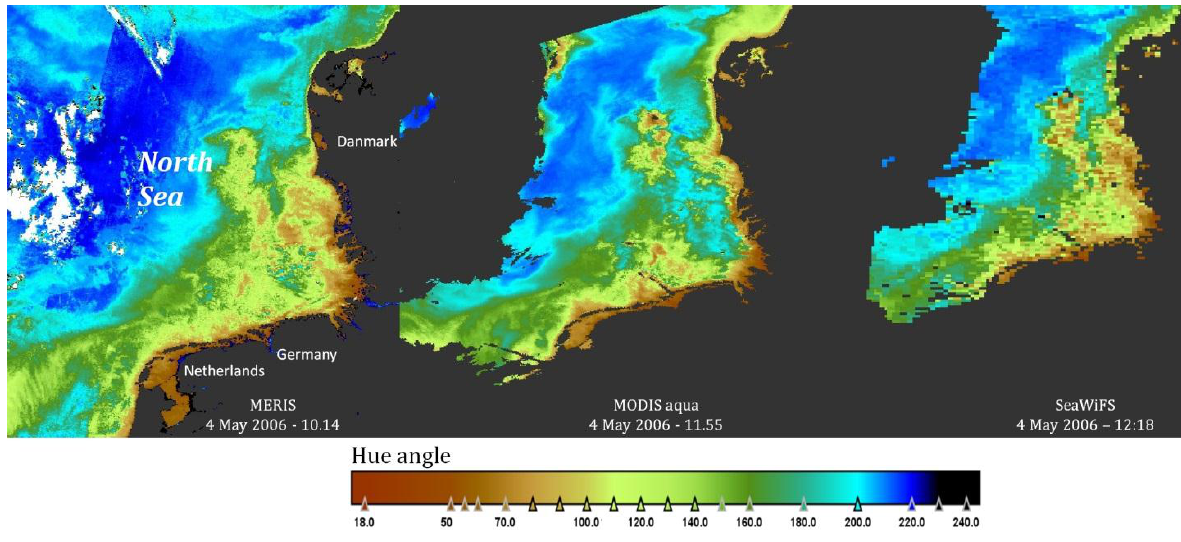
Figure 9. Hue angle image processing of MERIS, MODISA and SeaWiFS (left to right) with the code proposed in this manuscript. Area North Sea, date 4 May